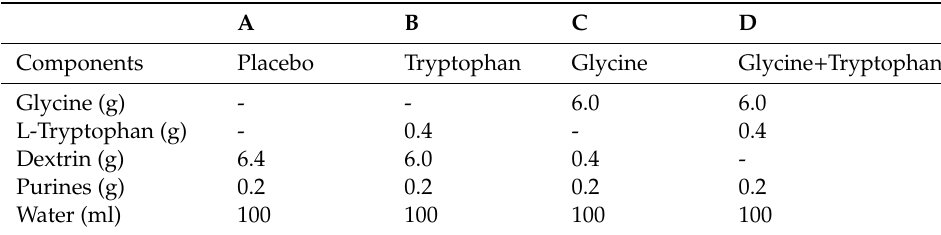
Table 1. Components of the test